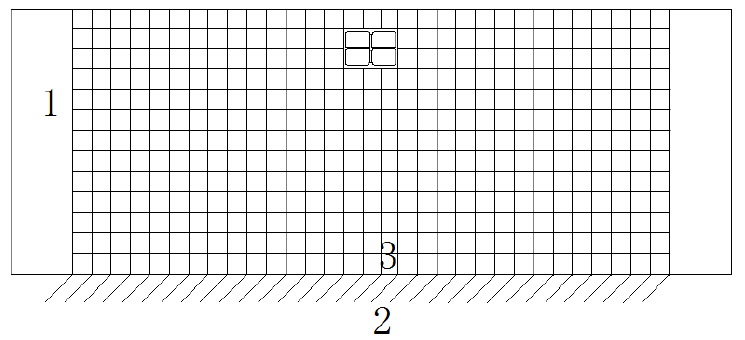
Figure 10. Schematic representation of the time ‐ history analysis calculation model.